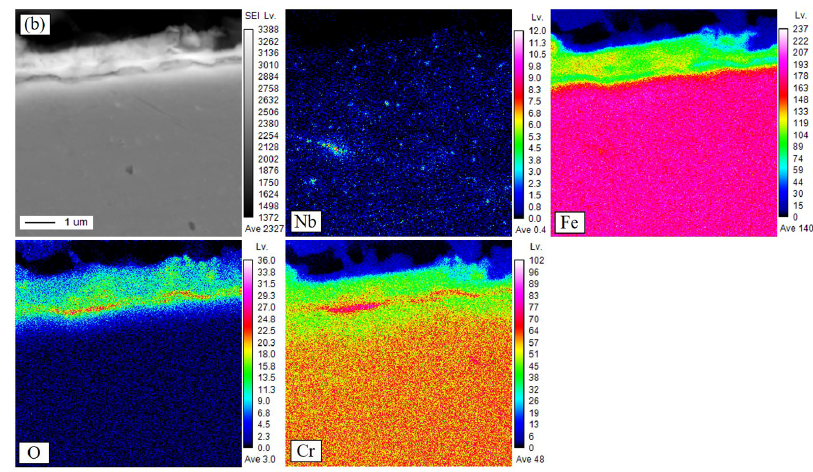
Figure 9. Cross-sectional morphologies and corresponding EPMA results of ( a ) S1 and ( b ) S2 after exposure to CO 2 at 650 °C under 3.5 MPa for 1000 h.